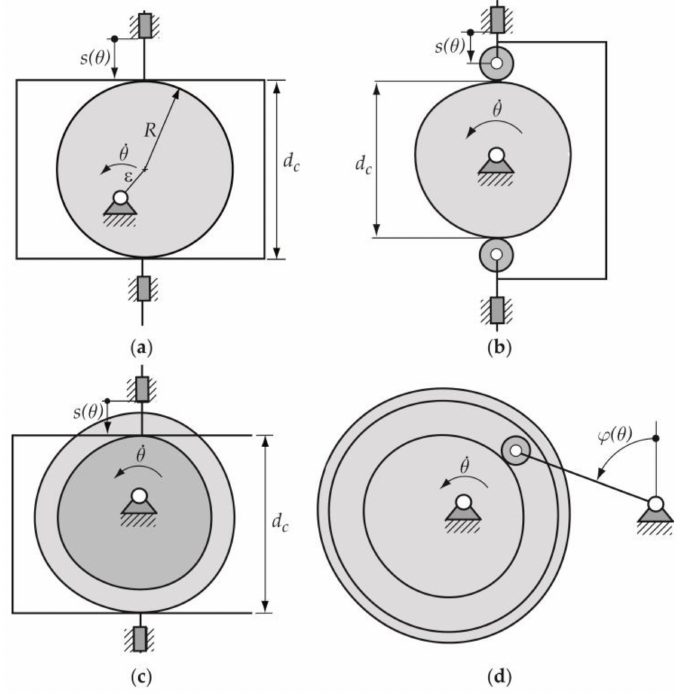
Figure 1. Types of planar desmodromic cam mechanisms: ( a ) constant-breadth cam; ( b ) constant- diameter cam; ( c ) conjugate cams; and ( d ) slotted cam mechanisms, respectively.